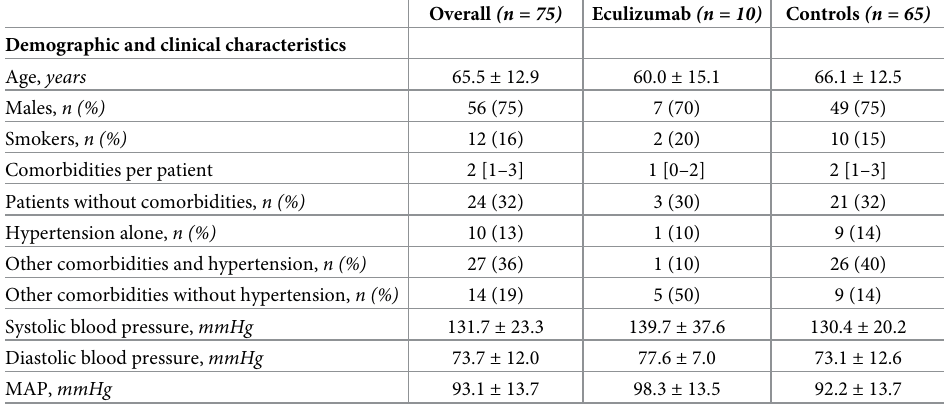
Table 1. Patient characteristics at baseline according to treatment